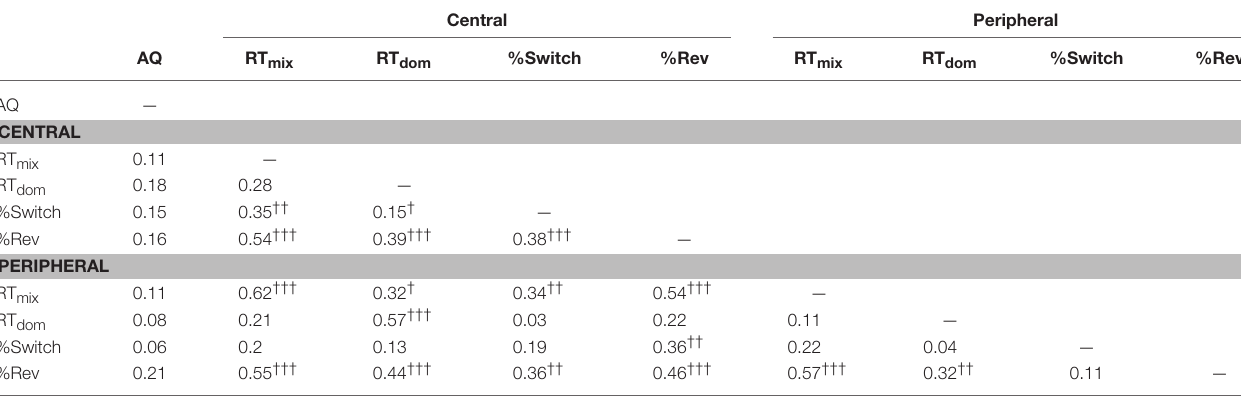
TABLE 5 | Kendall’s Tau correlations for AQ scores and “replay” response